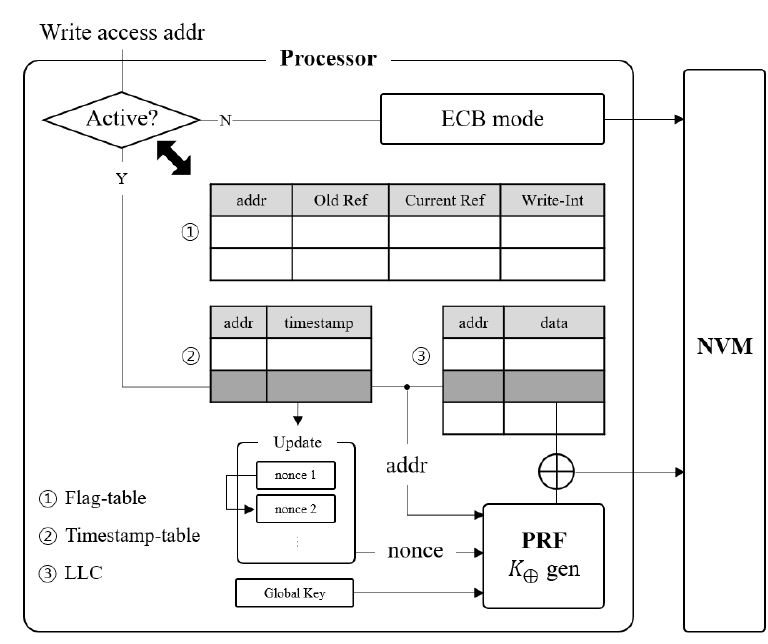
Figure 3. Overall outline of the Non-Volatile Memory (NVM)-shelf